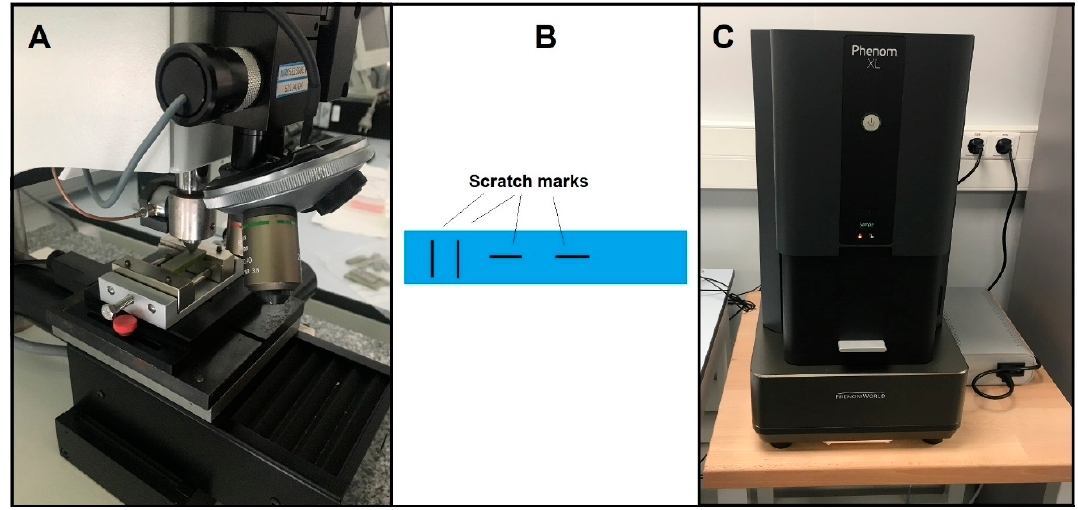
Figure 8. Micro scratch test. ( A ) scratch tester unit; ( B ) specimen; ( C ) scanning electron microscopy (SEM) ThermoFisher Scientific Phenom XL.